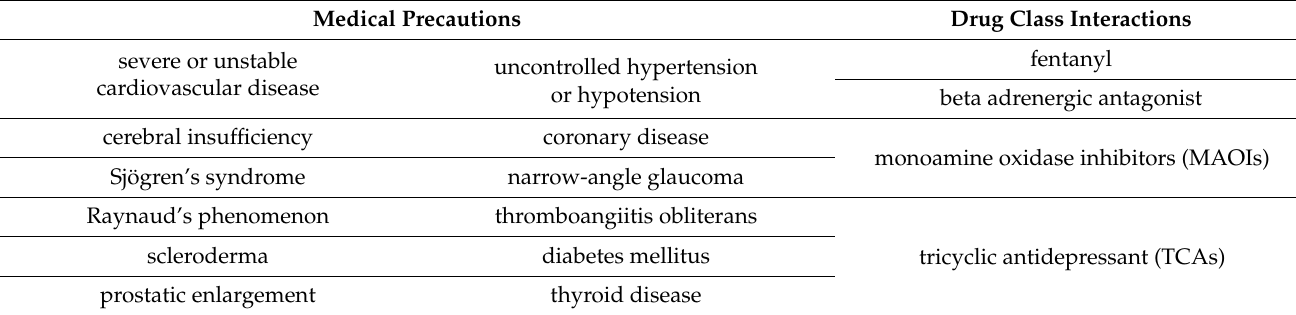
Table 2. Medical Precautions and Drug Interactions with ImDs 1